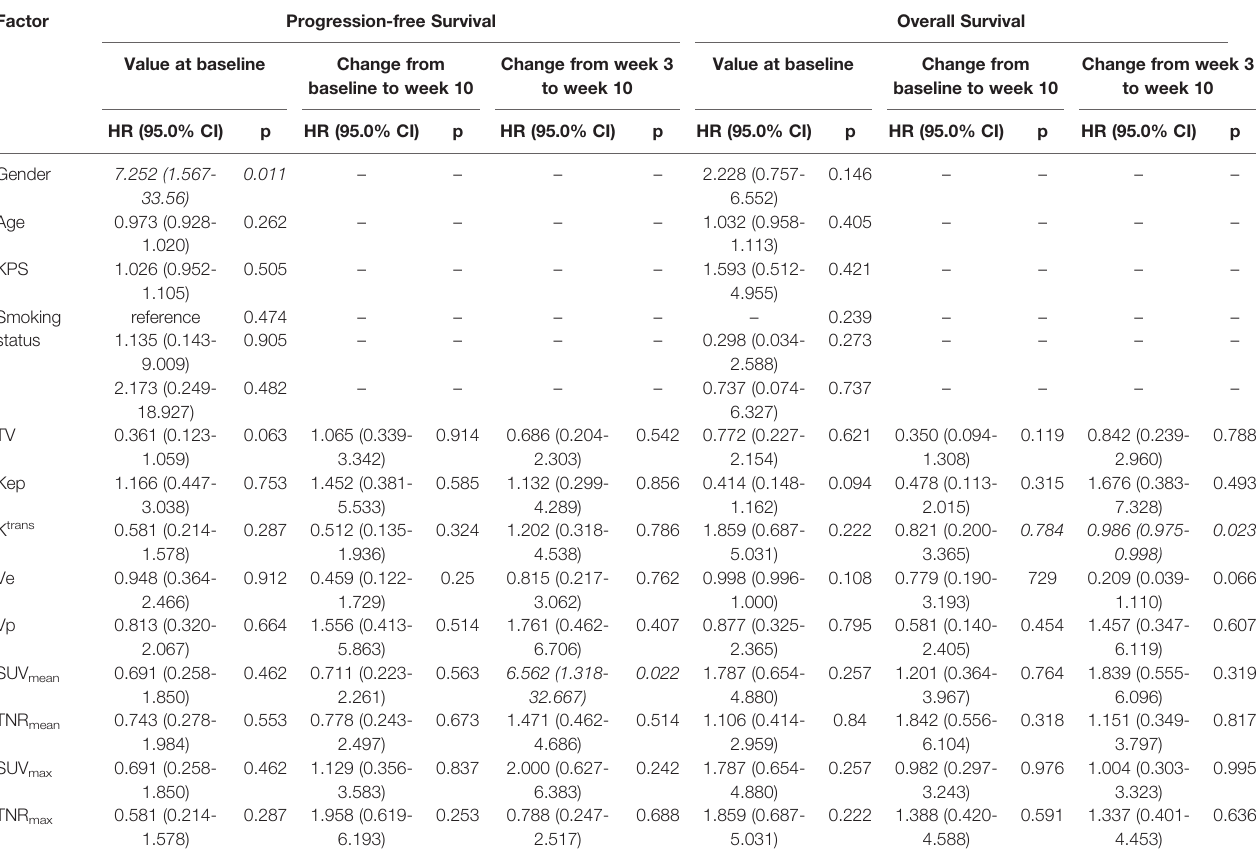
TABLE 5 | Univariate Cox regression analyses of factors predictive of